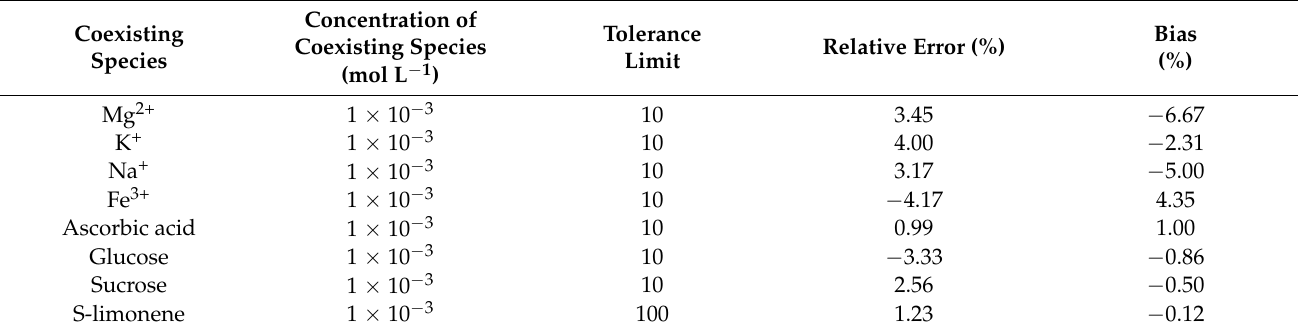
Table 3. The effect of coexisting species on the detection of 1 × 10 − 4 R-limonene (n = 5) using the Fe(TPFPP)Cl/AuNPs-S-Gr sensor.